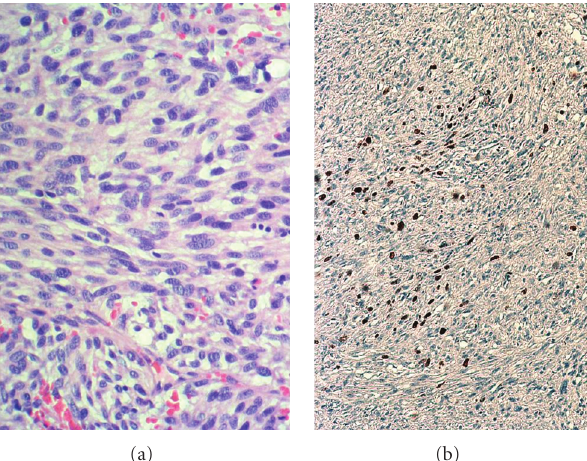
Figure 3: (a) Spindle cells appear with relatively homogeneous nuclei and scant cytoplasm. Low-grade atypia and few number of mitosis can be observed. H/E 400X. (b) the ki-67 immunostain shows a 60% nuclear expression of all spindle cells among the interstitial collagen.